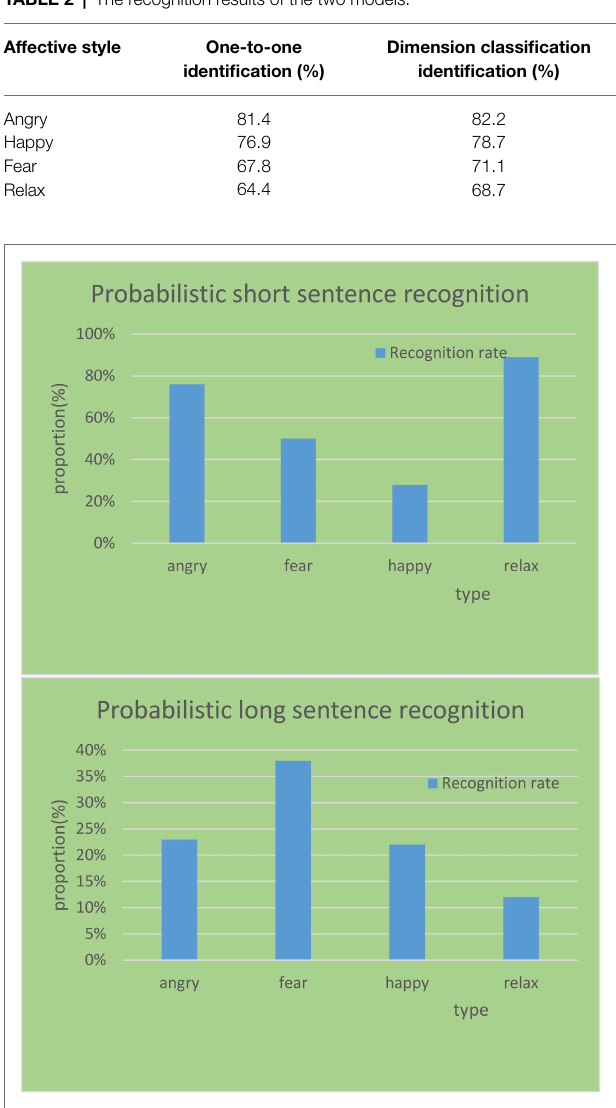
FIGURE 11 | Correction rates of different emotion types on long and short